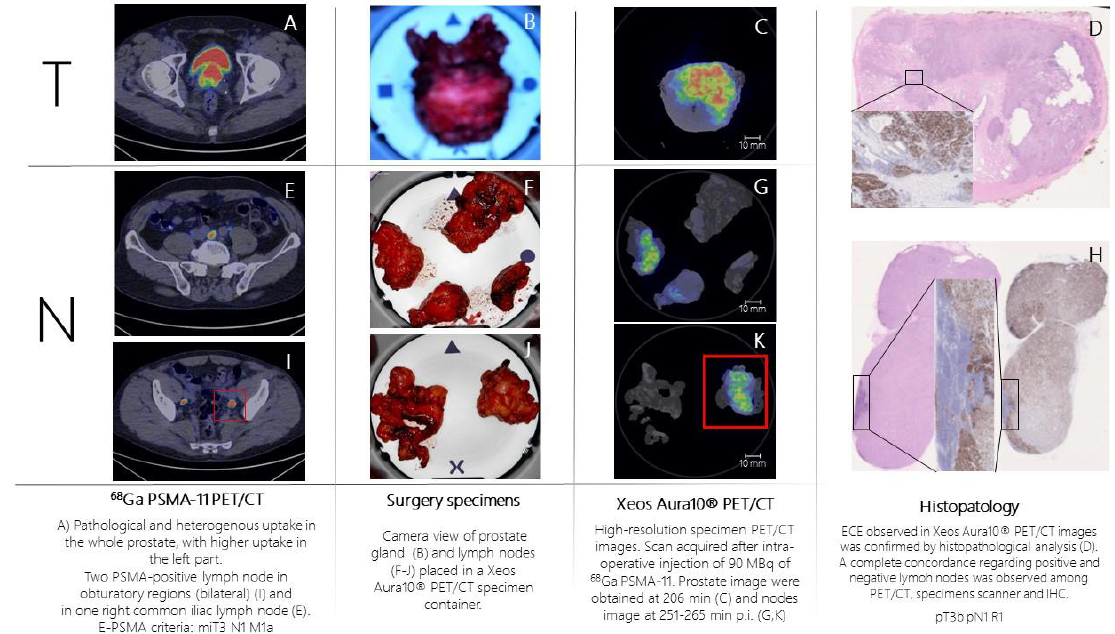
Figure 3. Patient 2 (prostate cancer): 68 Ga-PSMA-11 whole-body PET/CT images showed pathological PSMA uptake (high expression, E-PSMA Visual Score = 3) in the prostate ( A ) and in three pelvic lymph nodes ( E , I ). This figure also represented surgery specimen’s macro pictures ( B , F , J ), high-resolution specimen PET/CT images ( C , G , K ) and histopathological analysis in the specimens where immunohistochemical analysis (PSMA staining) was performed ( D , H ).